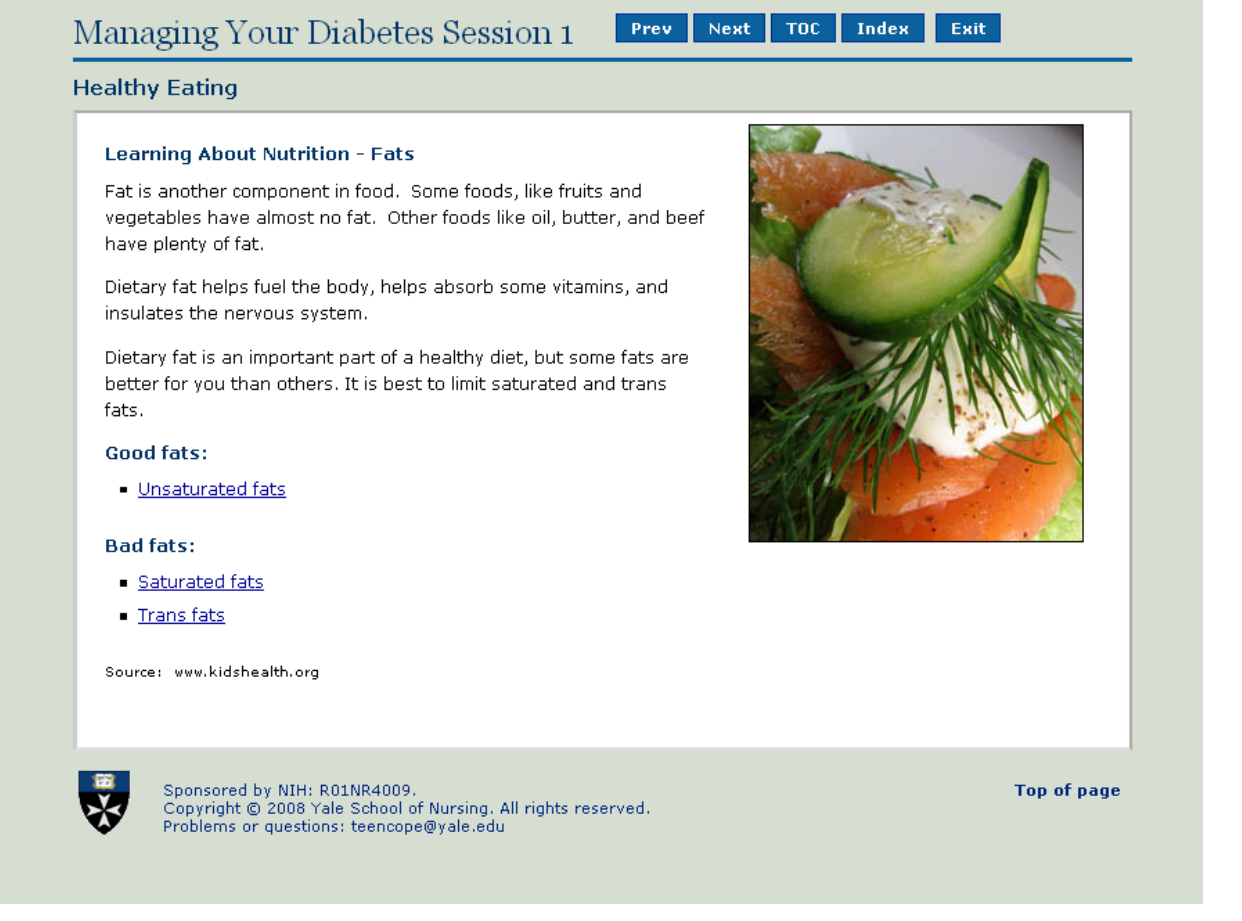
Figure 3. Managing Diabetes screenshot displaying webpage for nutrition